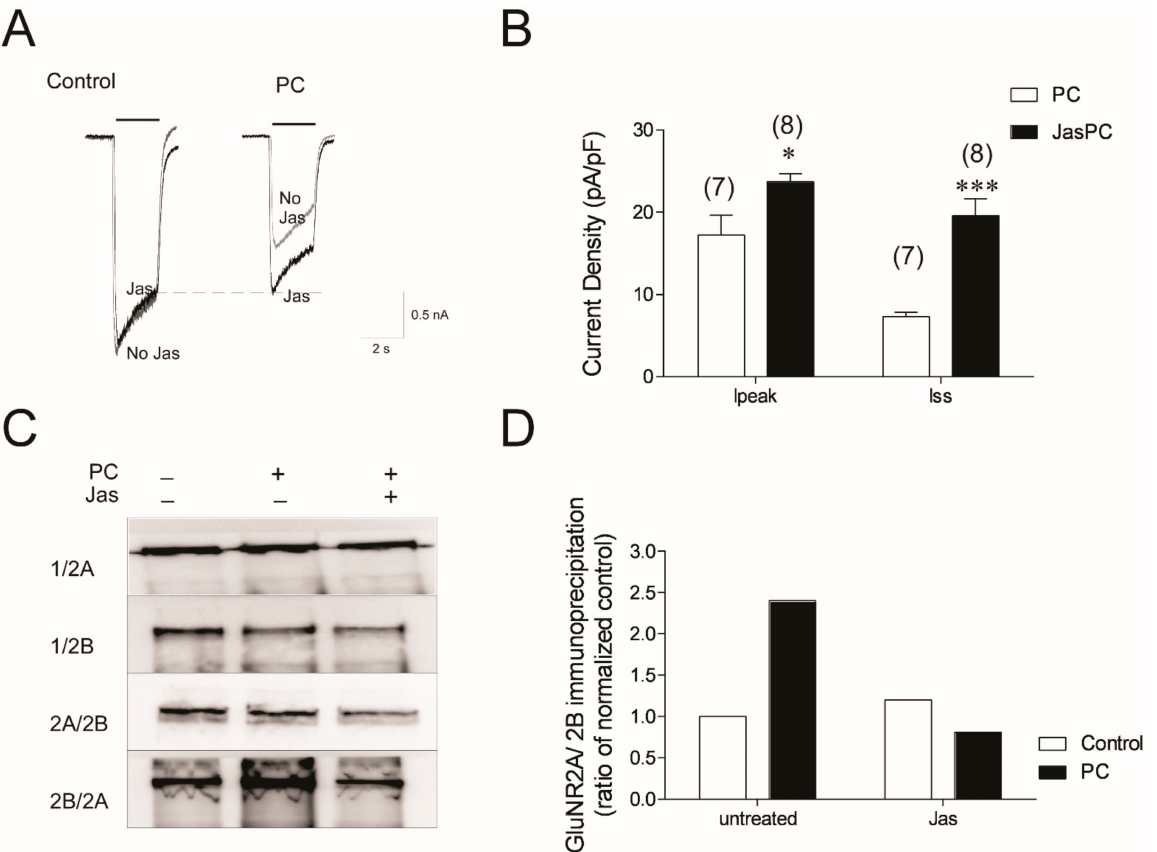
Figure 5. Actin stabilizer jasplakinolide partially alleviates the NMDA current reduction and reduces the formation of tri-heteromeric NMDAR in preconditioned neurons. ( A ) Cortical neurons were incubated with 3 µ M of jasplakinolide for 1 h prior to the 30 min OGD or sham OGD. The whole-cell currents from the jasplakinolide-treated cells (black traces) were compared to those recorded from untreated cells from their sister cultures (grey graces). ( B ) Peak (Ipeak) and steady-state (Iss) current densities from control (white) and preconditioned cells in the presence or absence of jasplakinolide. Data shown are mean ± sem. n = 6 * denotes p < 0.05 vs. PC-only-treated cells *** denotes p < 0.001 vs. PC-only-treated cells. ( C ) Control, or PC neurons with and without 3 µ M of jasplakinolide incubation were used in immunoprecipitation assay. Samples were immunoprecipitated with GluN1, GluN2A, or GluN2B antibody, and blotted with GluN2A and GluN2B antibody (shown as IP antibody/blot antibody). ( D ) Quantification of the blots in ( C